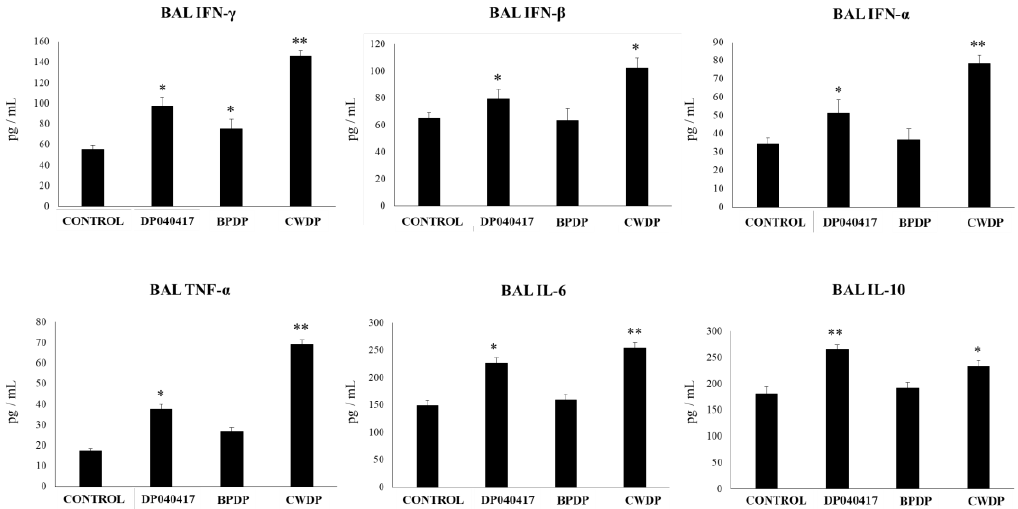
Figure 3. Effect of Dolosigranulum pigrum 040417 on respiratory cytokines. Viable (DP), bacterium-like particles (BPDP) or cell wall (CWDP) from D. pigrum 040417 were nasally administered to infant mice during five consecutive days. Non-treated infant mice were used as controls. Levels of tumor necrosis factor (TNF)- α , interferon (IFN)- α , IFN- β , IFN- γ , interleukin (IL)-6, and IL-10 were determined in broncho-alveolar lavages (BAL) one day after the last treatment. Experiments were performed with 5–6 mice per group. The results represent data from three independent experiments. Significantly different when compared to control * p < 0.05 or ** p < 0.01.